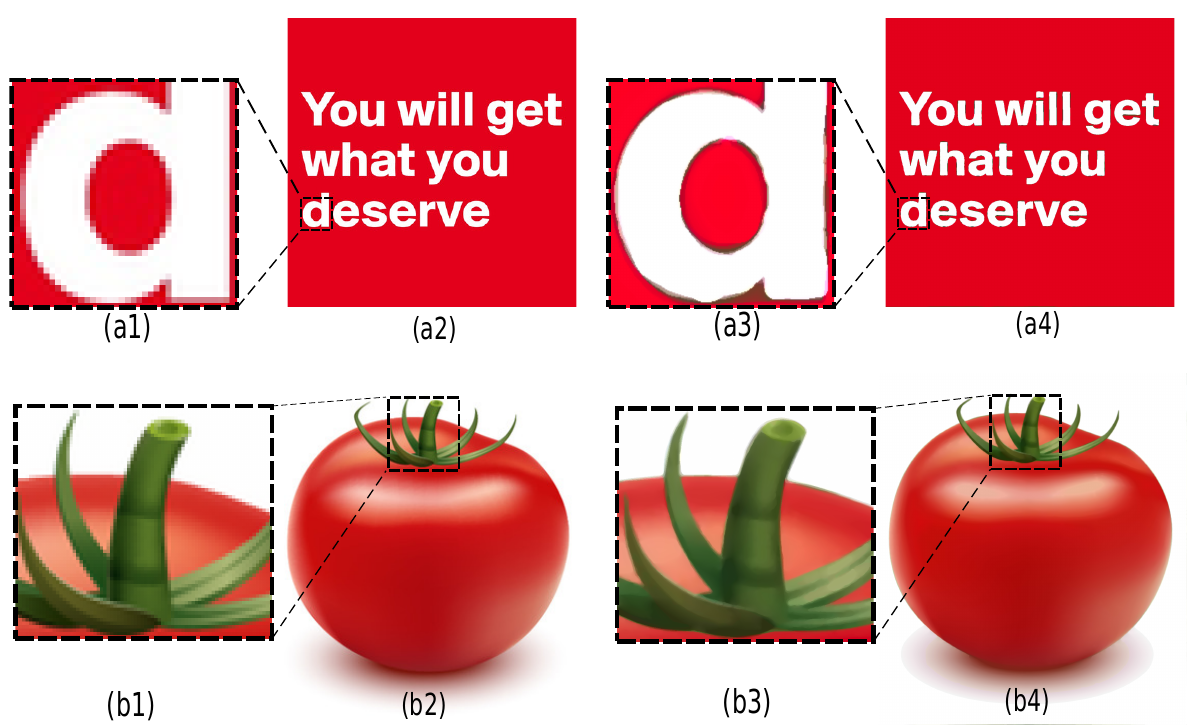
Figure 18. The super-resolution effect on a text image ( a ) and a graphic generated by gradient meshes ( b ). ( a1,b1 ) Enlarged areas of the input images (500 2 pixels) ( a2,b2 ). ( a3,b3 ) Enlarged areas of SDMD reconstructions (3000 2 pixels) ( a4,b4 ).